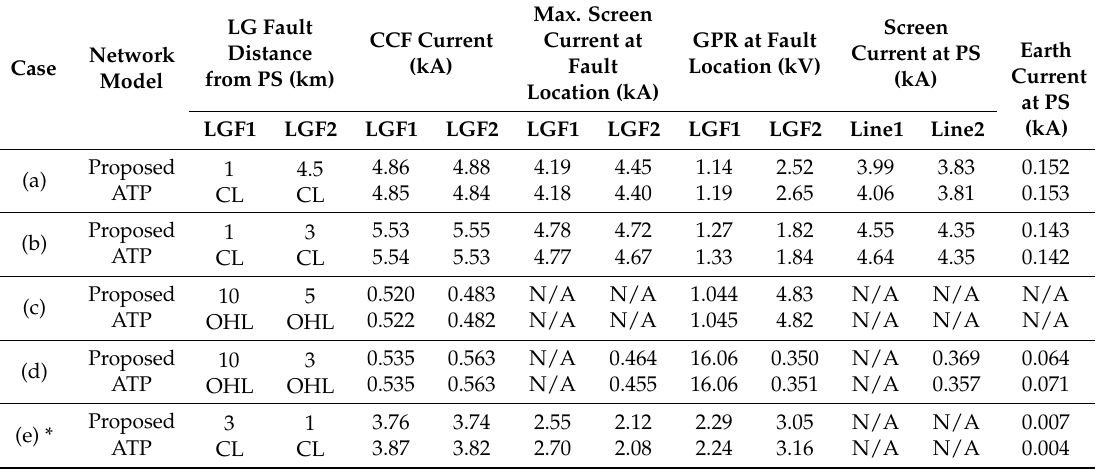
Table 2. Simulation results for CCFs occurring in two different